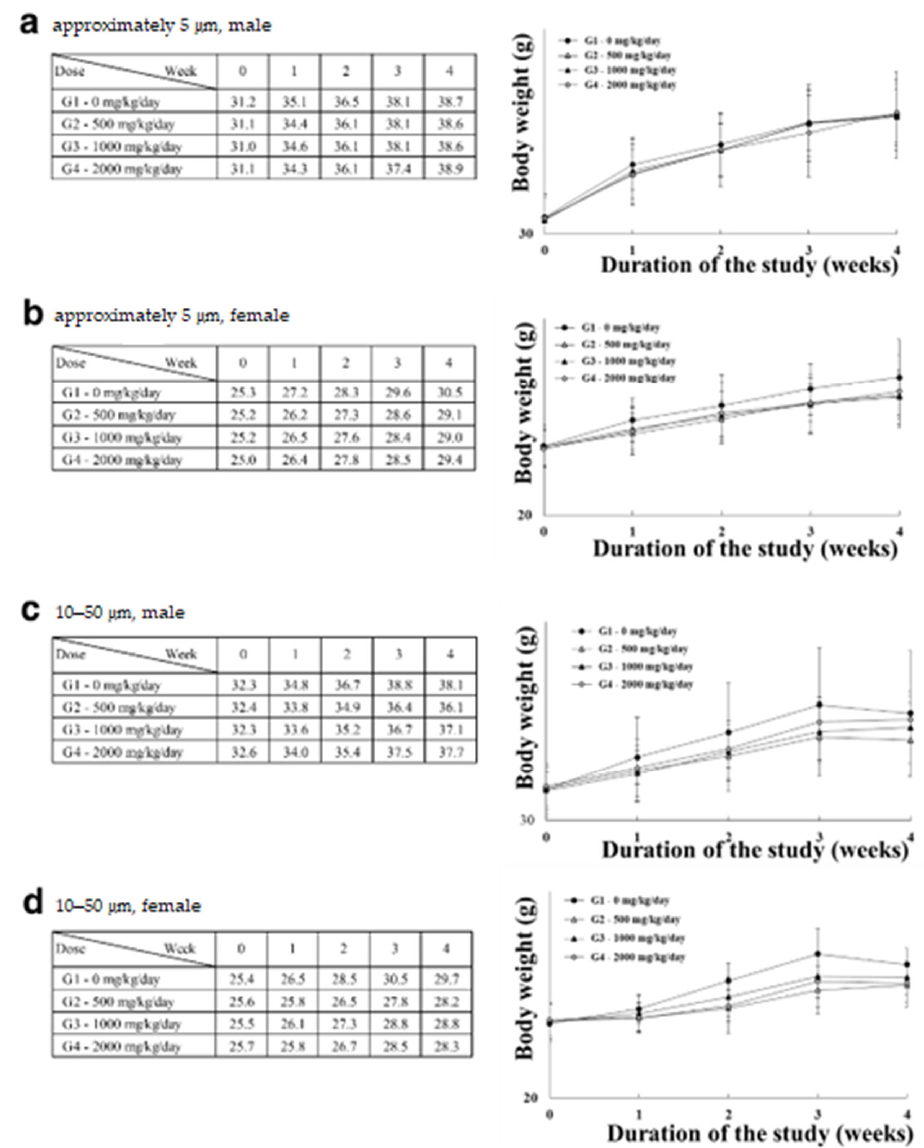
Figure 3. Male and female bodyweight changes after four weeks of repeated dosing with approxi- mately 5 µ m ( a , b ) and 10–50 µ m ( c , d ) PTFE